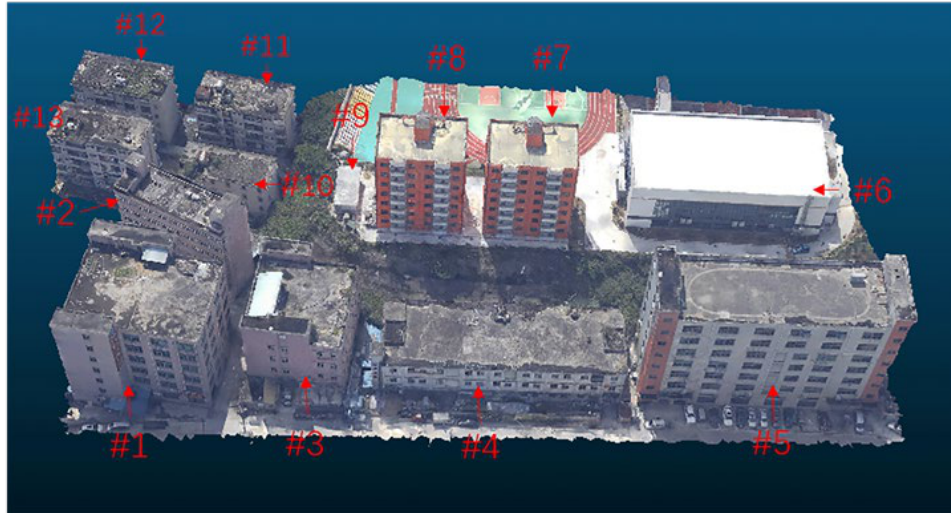
Figure 11. A scene of photogrammetric mesh model.